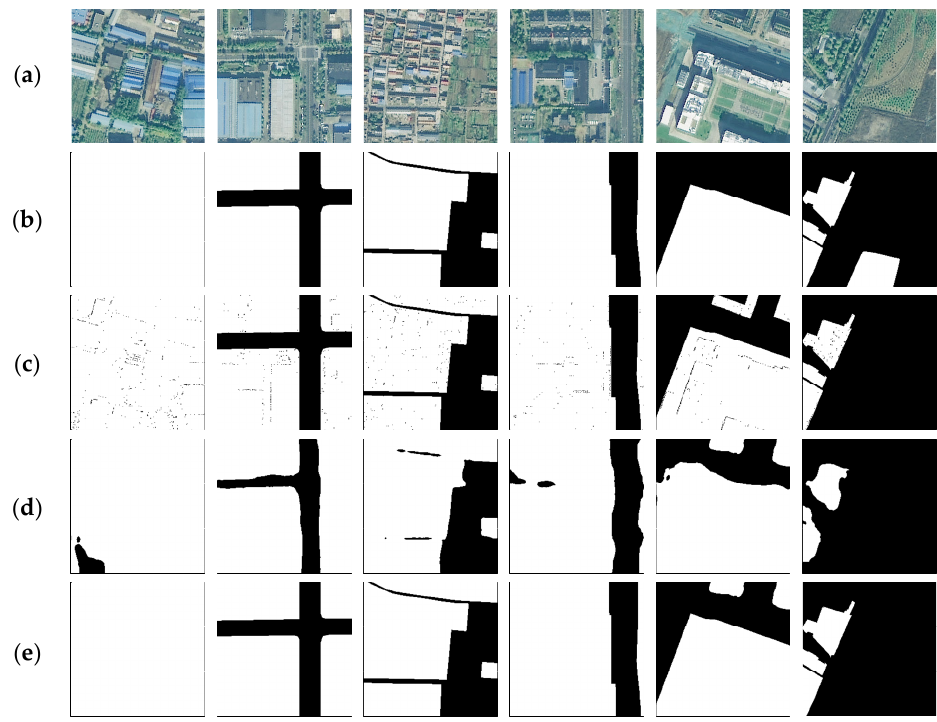
Figure 15. Update results obtained by the post ‐ processing update strategies, ( a ) 2019 image, ( b ) 2018 ground truth, ( c ) 2019 ground truth, ( d ) CycleGAN, ( e ) CycleGAN ‐ post ‐ processing.